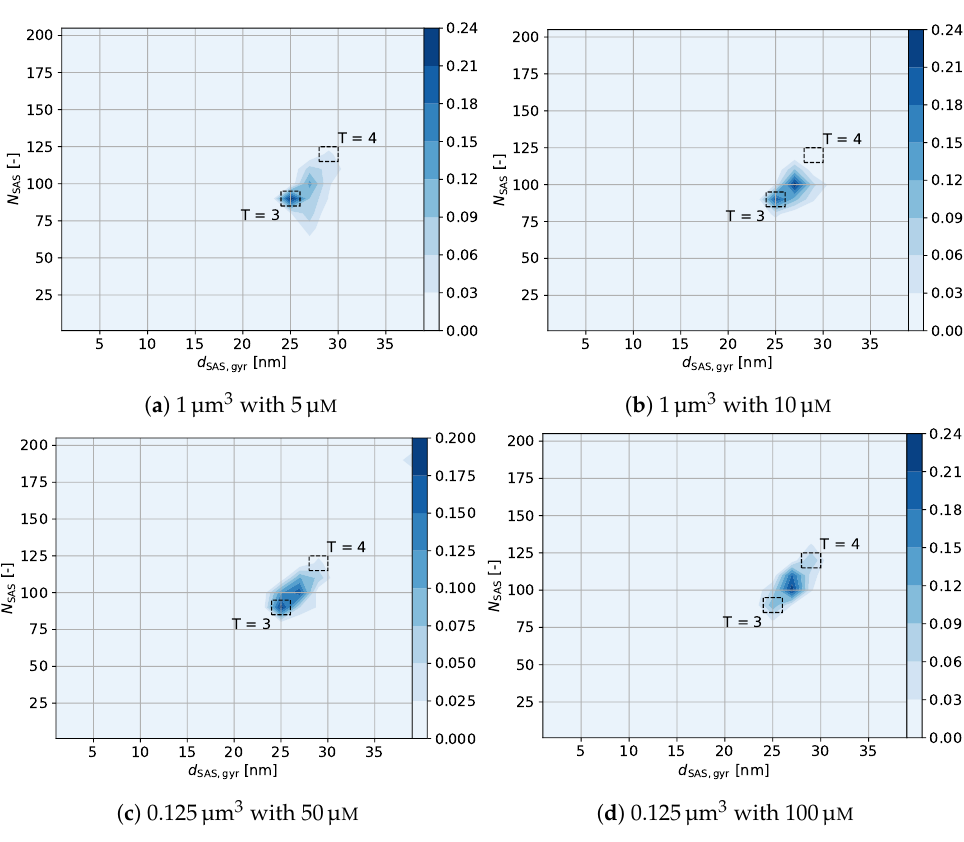
Figure 14. Final distribution of numbered size versus diameter of gyration (averaged over last ten saving